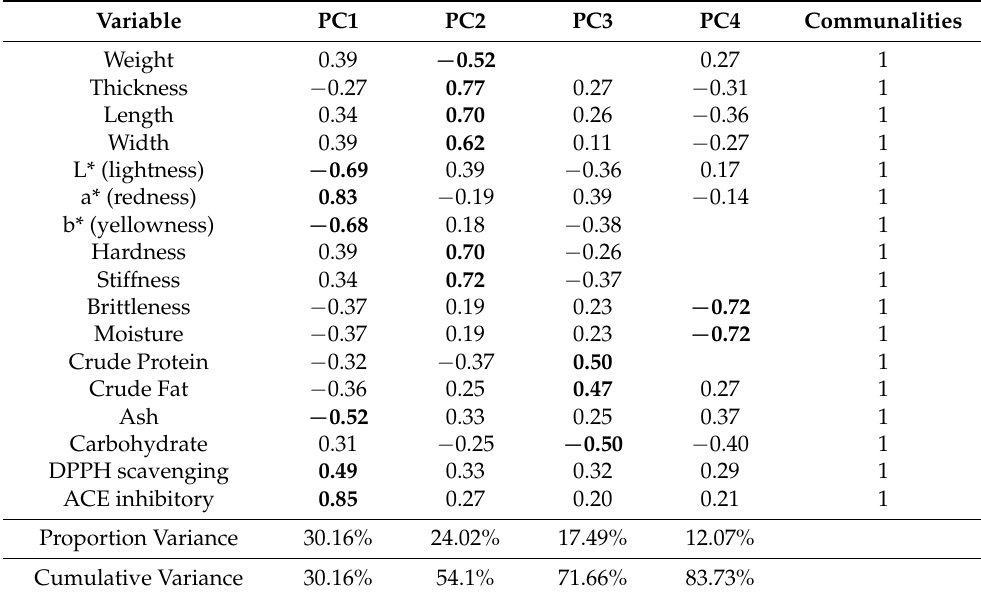
Table 8. Score coefficients derived from principal component analysis of snack bars product